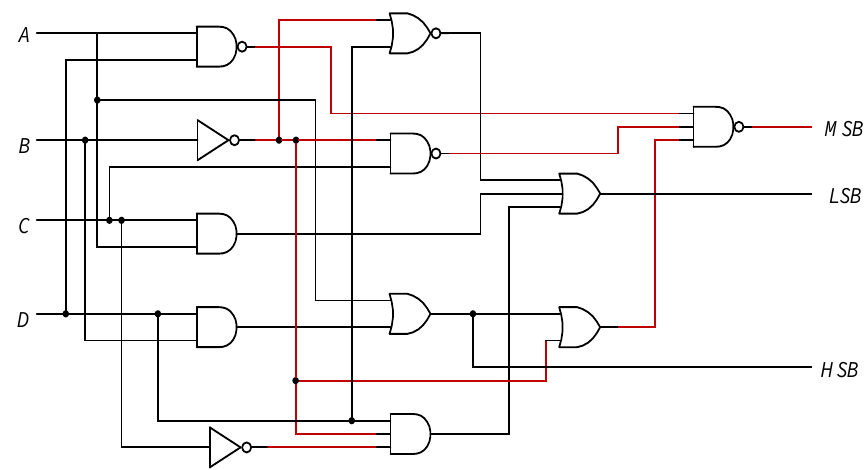
Figure 9. A schematic of the encoder circuit.